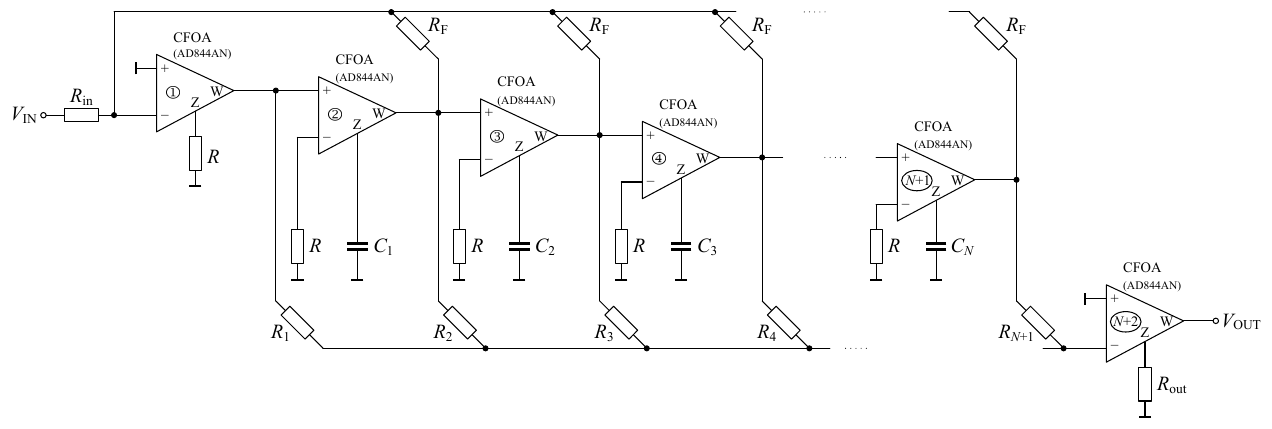
Figure 8. CFOA-based circuit implementation of the proposed